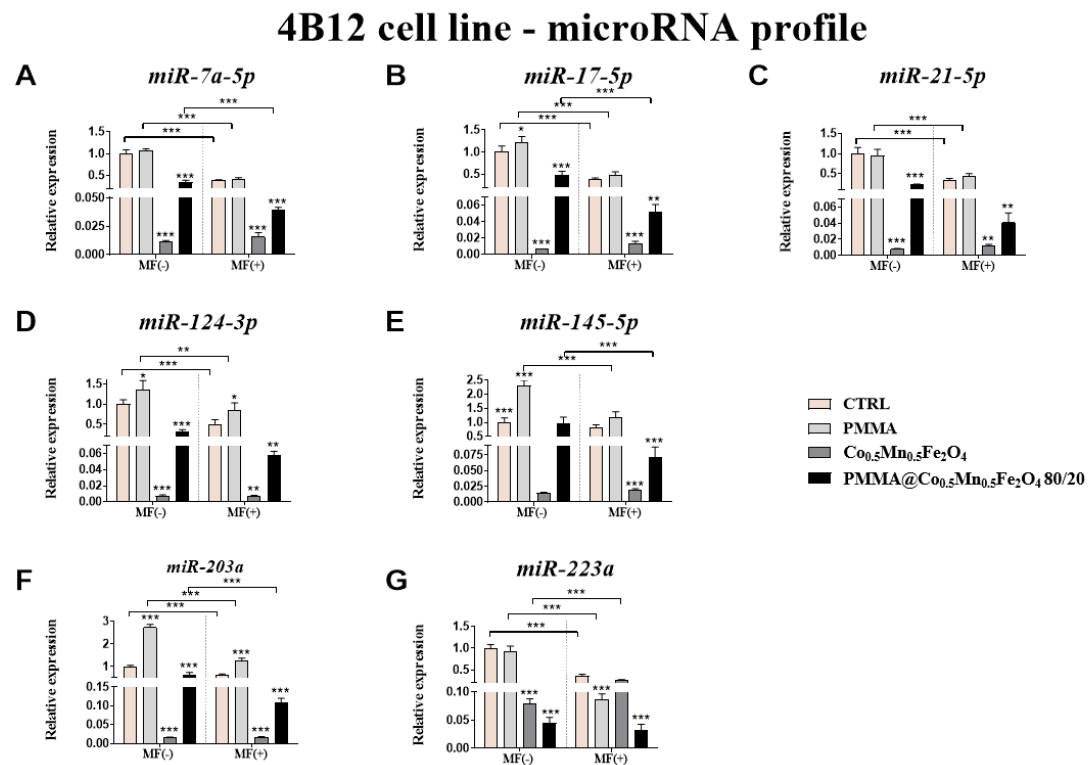
Figure 12. The impact of PMMA and its modification on the microRNA profile associated with osteoblastogenesis and osteoclastogenesis expression of miR-7a-5p ( A ), miR-17-5p ( B ), miR-21-5p ( C ), miR-124-3p ( D ), miR-145-5p ( E ), miR-203a ( F ) and miR-223a ( G ) in the magnetic field condition towards mouse pre-osteoclasts (4B12 cell line). Statistical differences are indicated by * p < 0.005; ** p < 0.001 and *** p < 0.0001.